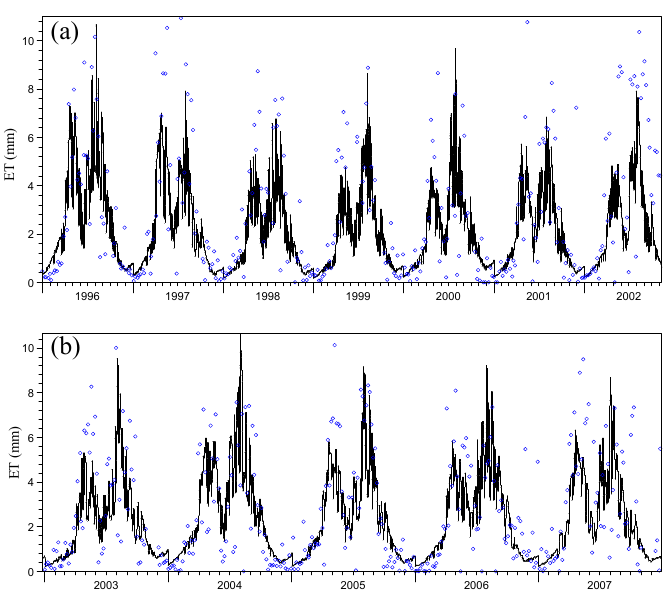
Figure 5. Time series of ET modeled by MIKESHE (full line) are compared to the observed evapotranspiration value (blue circle) in the calibration period ( a ) and validation period ( b ).